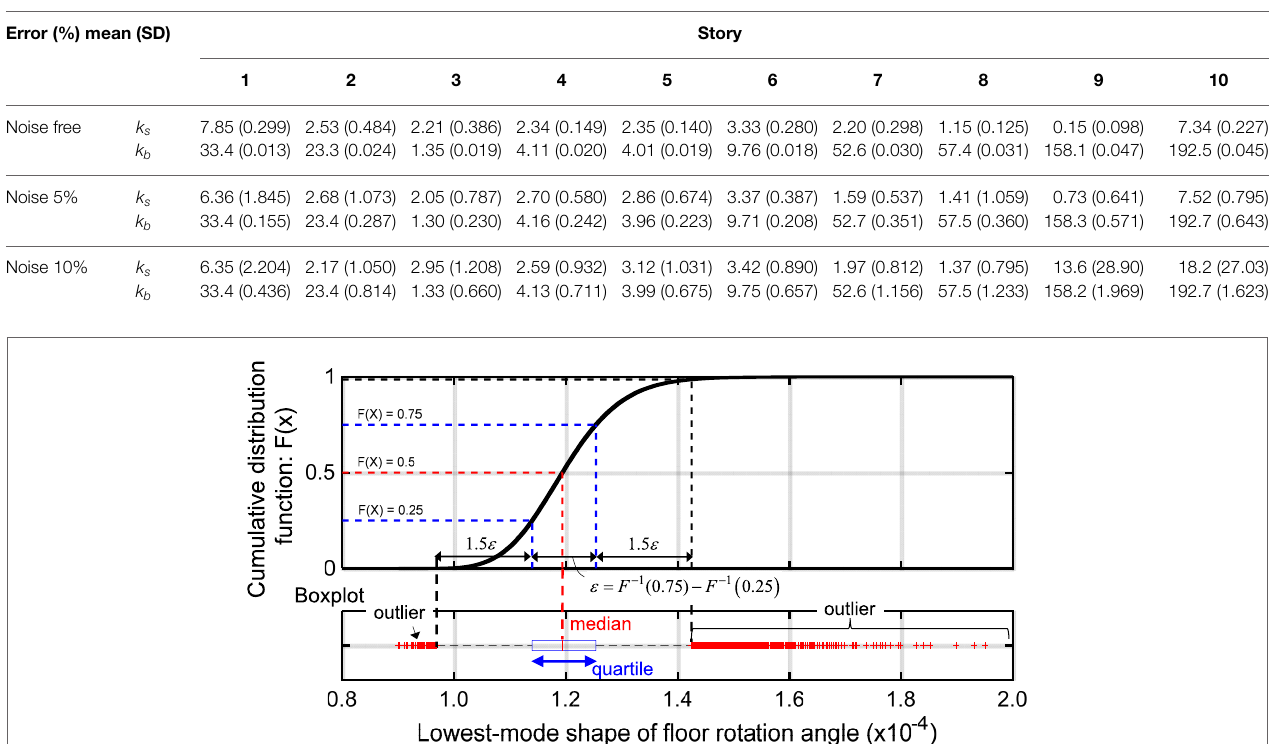
TABLE 3 | Mean and SD of error ratio of identified stiffnesses in non-simultaneous measurement using empirical equation (10 times investigation using different micro-tremors). Error (%) mean (SD)